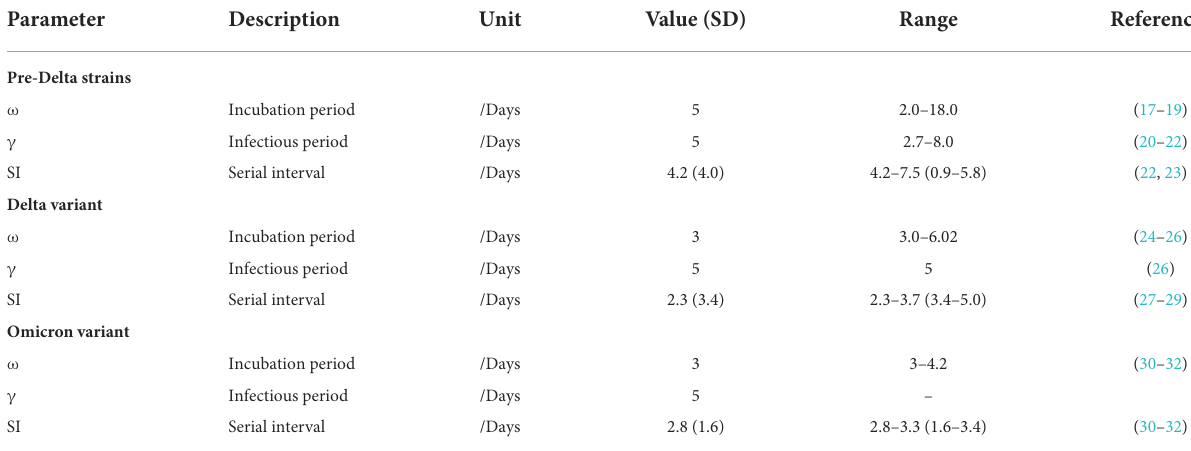
TABLE 1 Description and source of